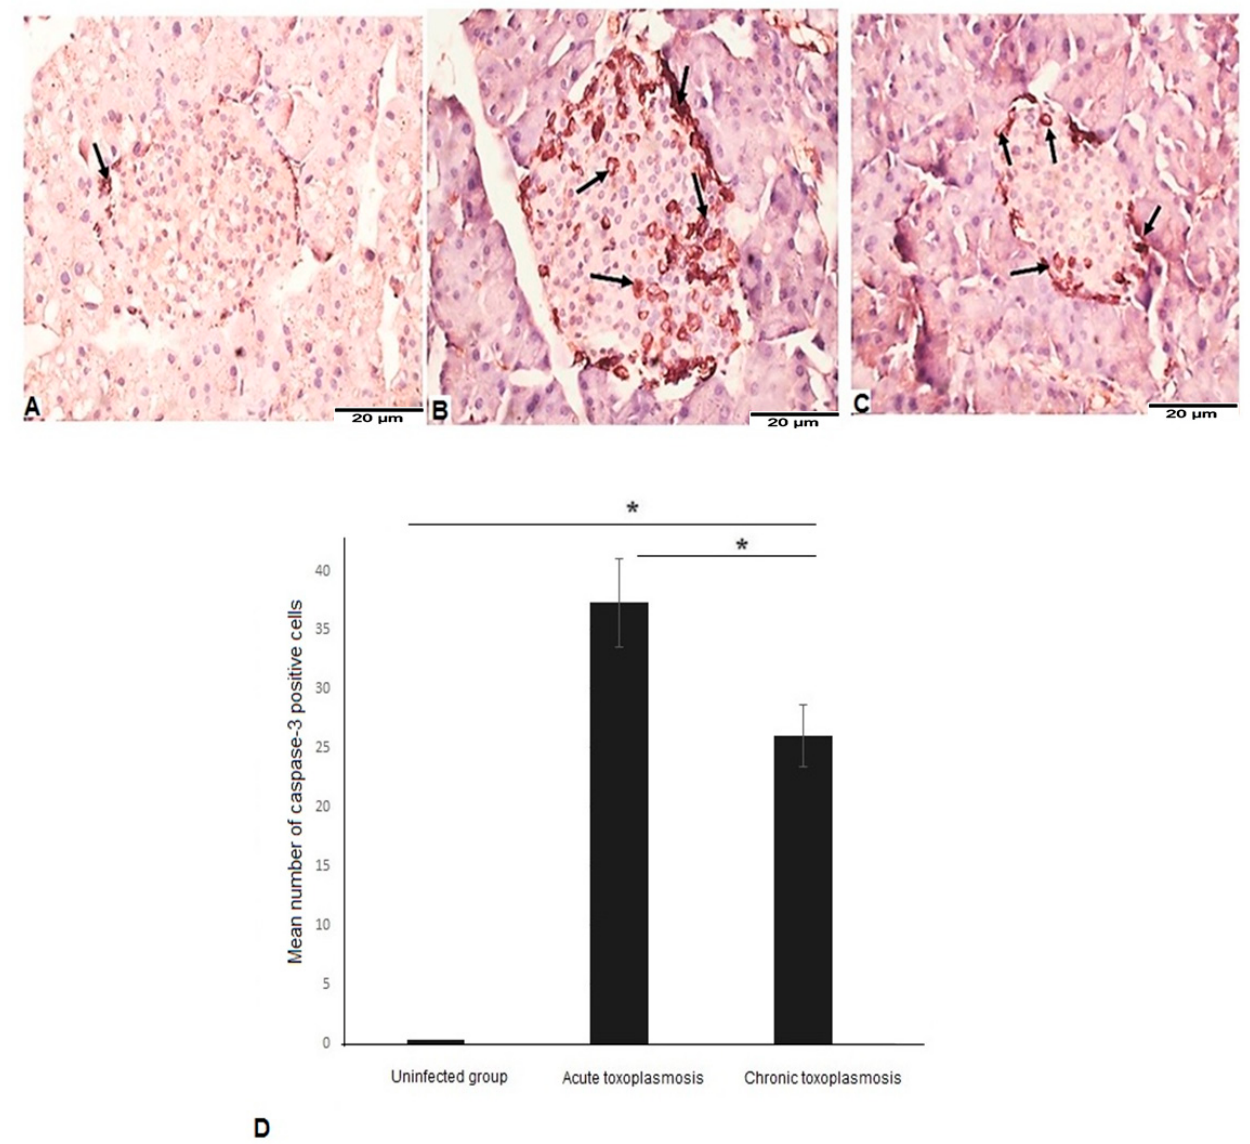
Figure 4. Acute and chronic toxoplasmosis induced apoptotic cell death in pancreatic islets of Langer- hans. Pancreatic tissue sections of mice from different groups ( n = 10/group) were stained with anti-caspase-3 antibody. ( A ) Representative image of pancreatic tissue sections of uninfected mice showing weak caspase 3 signal. ( B ) Representative image of pancreatic tissue sections of the acute toxoplasmosis group showing stronger caspase-3 staining and higher number of caspase-3-postive cells (apoptotic cells). ( C ) Representative image of pancreatic tissue sections of the chronic toxoplas- mosis group with high number of caspase-3-postive cells but less than the acute toxoplasmosis group. ( D ) Number of caspase-3 positive cells /HPF in islets of Langerhans of different mice groups. Data are expressed as mean ± SD ( n = 10). Asterisks (*) indicate statistically significant difference; p <